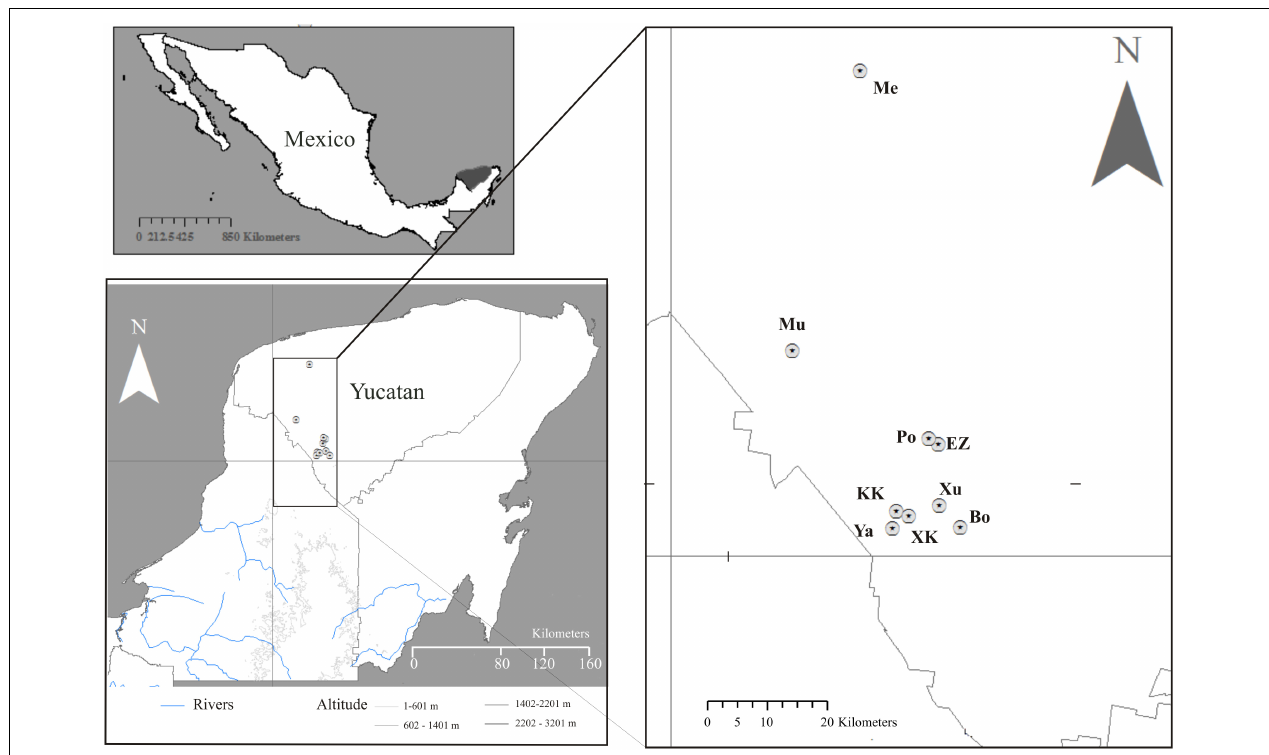
FIGURE 1 | Study area in Mexico and Yucatan State Collection sites are indicated: Urban, Mérida City (Me); Homegarden (“Solares Mayas”: Emiliano Zapata (EZ) and Xul (Xu); Median subdeciduous tropical forest: Kaxil Kiuic (KK) and Yaxhachén (Ya); Secondary vegetation: X’kobenhaltun (XK), Bombahaltún (Bo), and Potoit (Po).